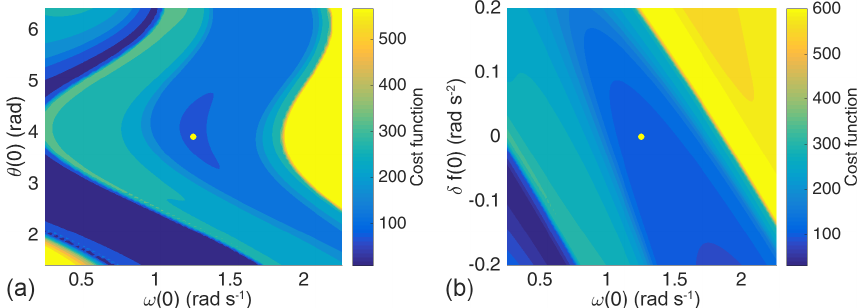
Figure 7. Escaping an apparent local minimum. (a) Cost-function values as a function of θ (0) and ω (0), in a region of phase space where a local minimum is present in this slice (yellow dot). The same cost function, but oriented along a slice with constant θ (0) = 0 in the dimensions of δf (0) and ω (0). The local minimum in the first two dimensions is no longer an extremum in the other two dimensions or the combined three-dimensional (3-D) space. This case used T = 10s for